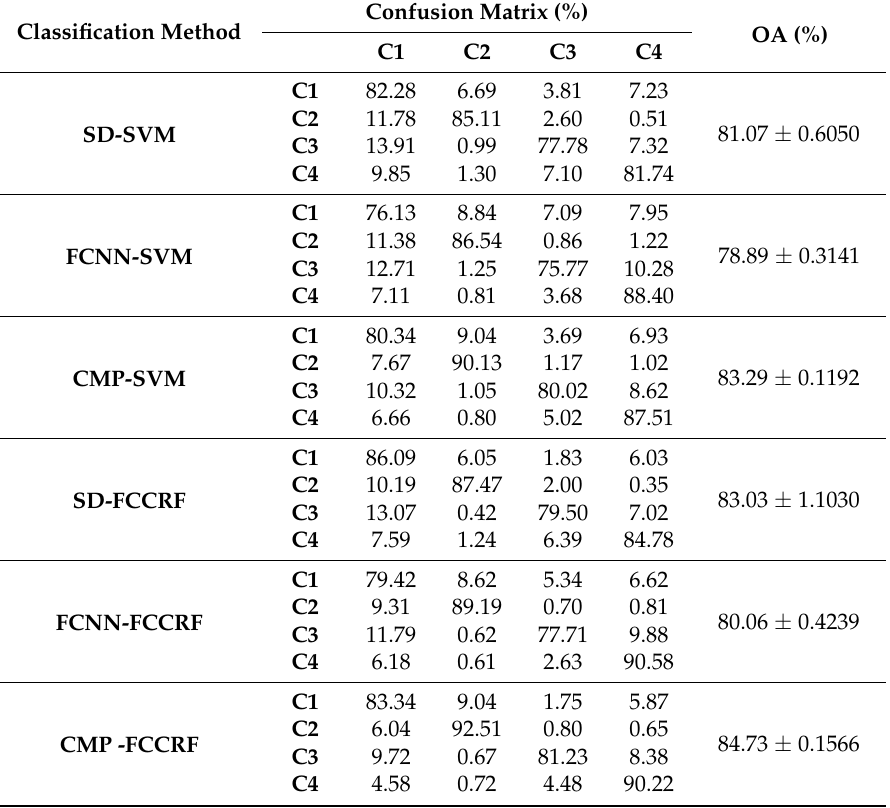
Table 3. Confusion matrix and classification accuracy of different